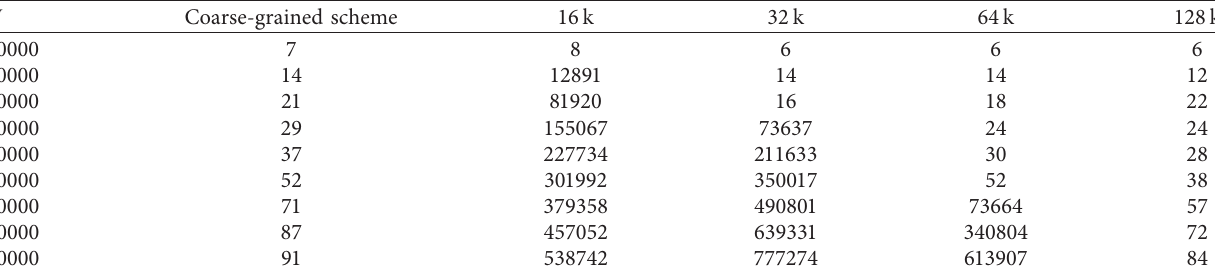
Table 4: Performance of the CDP-based scheme. Threshold from 16k to 128k.